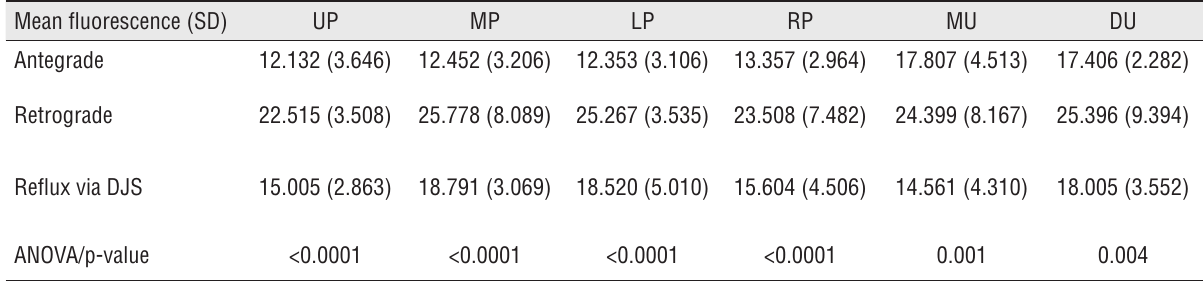
Table 1 - Mean fluorescence, standard deviation and AnOvA analysis of the 3 methods at 6 pre-defined points. Mean fluorescence (SD) UP MP